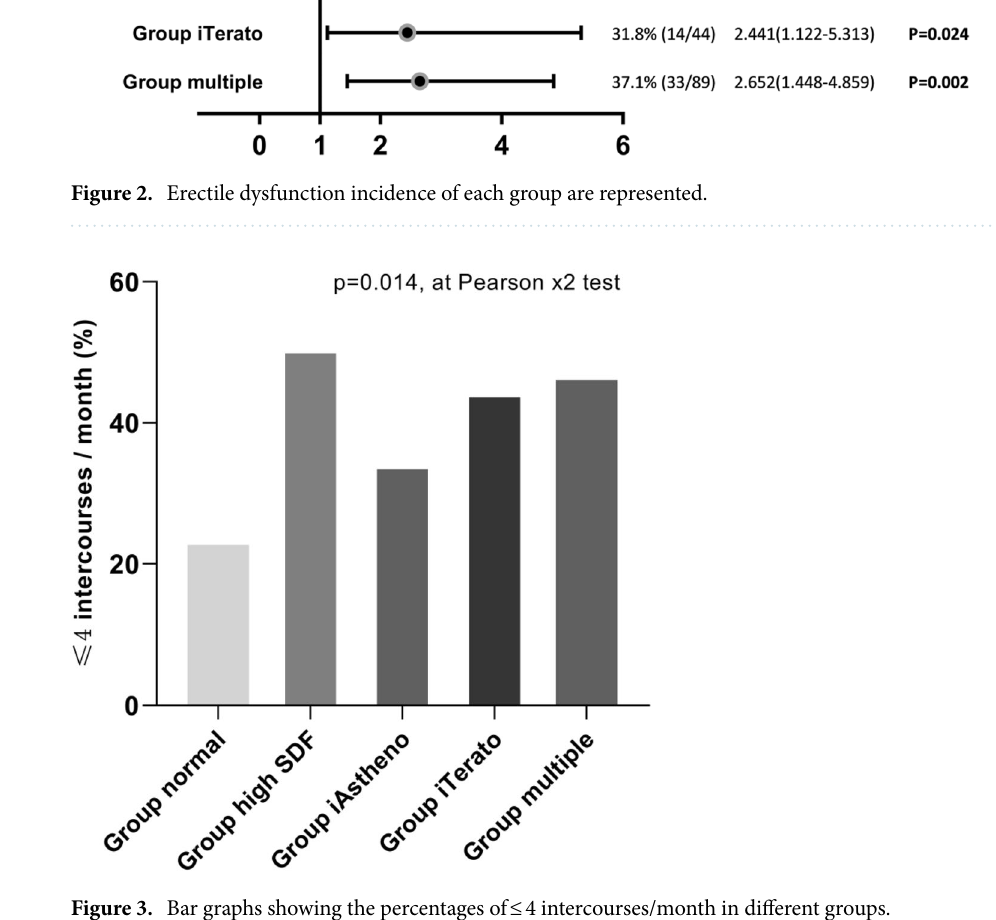
Figure 3. Bar graphs showing the percentages of ≤ 4 intercourses/month in different